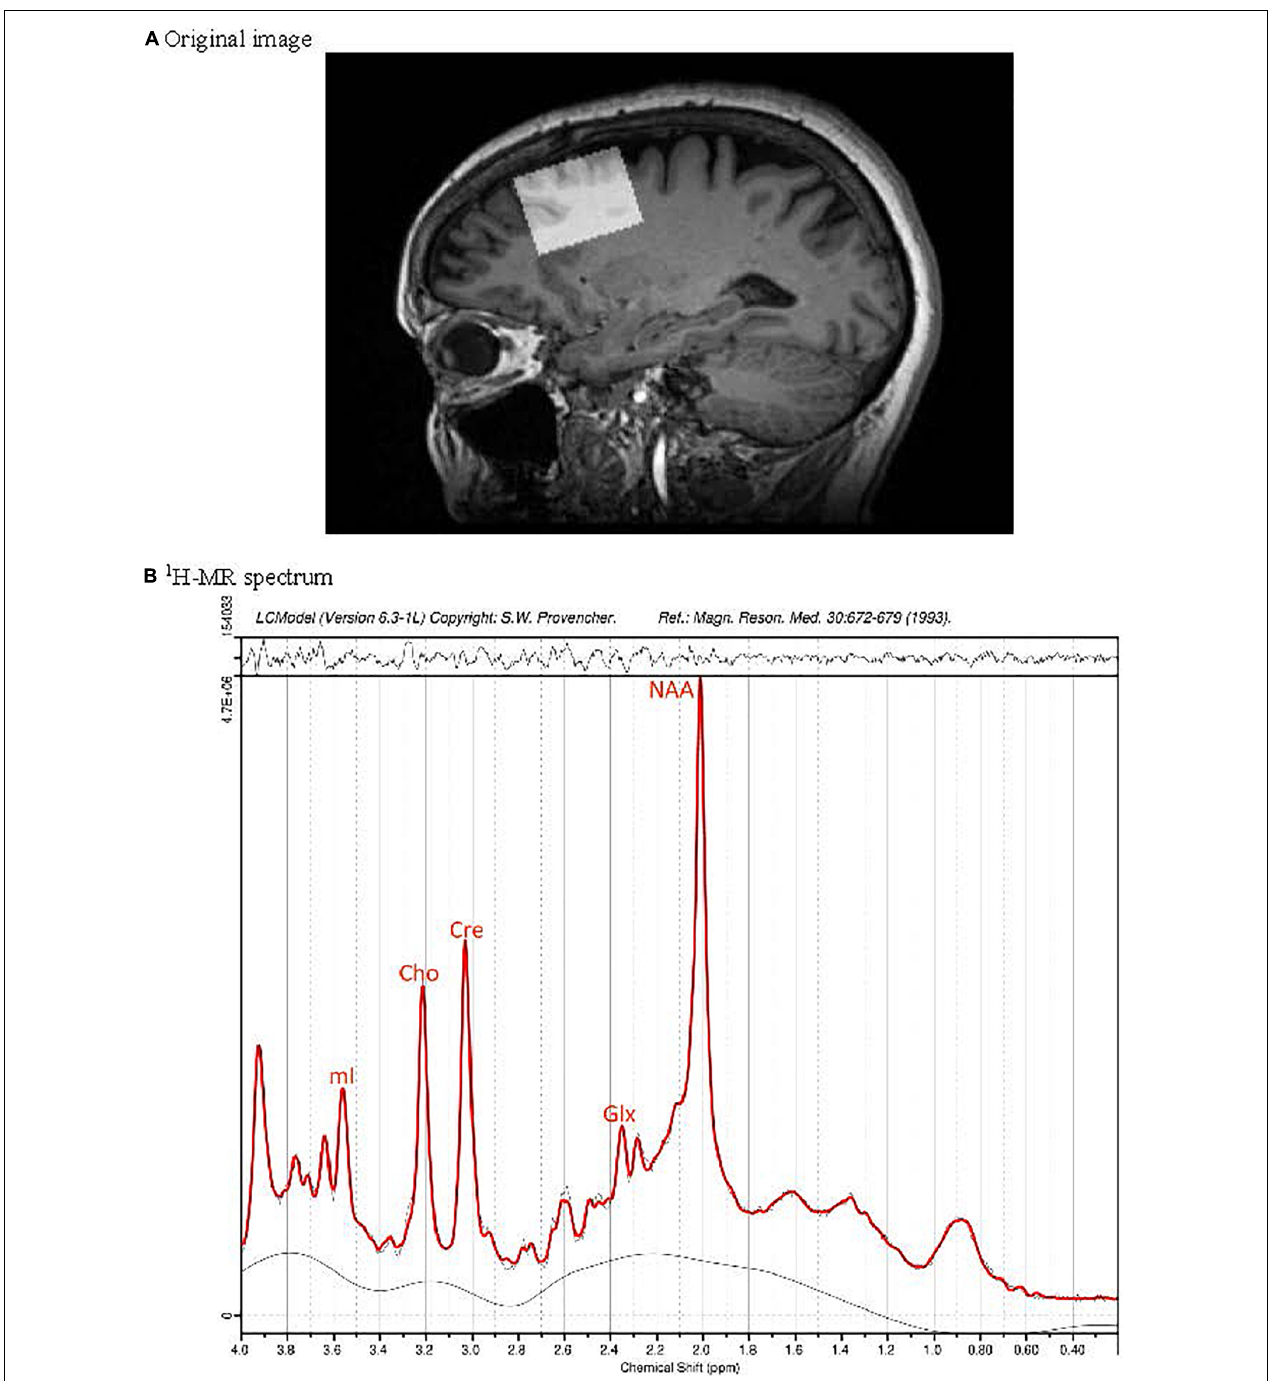
FIGURE 1 | Position of the MRS voxel in the dorsolateral prefrontal cortex of a cognitively normal participant without PD on a sagittal slice of the 3D T1 weighted MRI data set (A) . Subplot (B) presents the corresponding 1 H-MR spectrum (black) and fit (red).